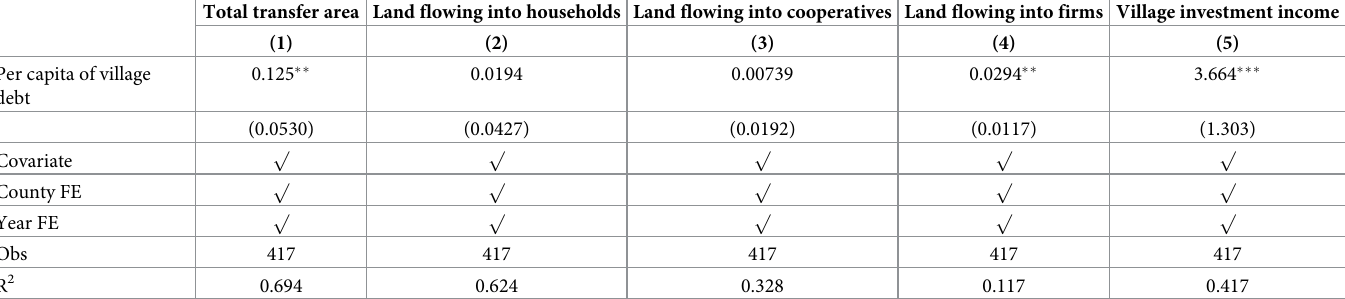
Table 7. Robust check of influence of village debt on farmland